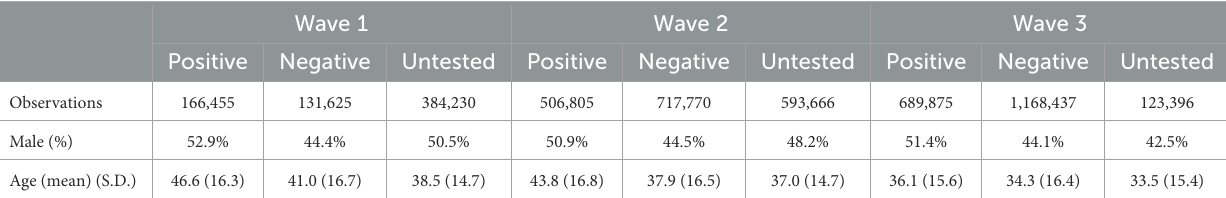
TABLE 1 Characteristics of suspect cases by wave and testing